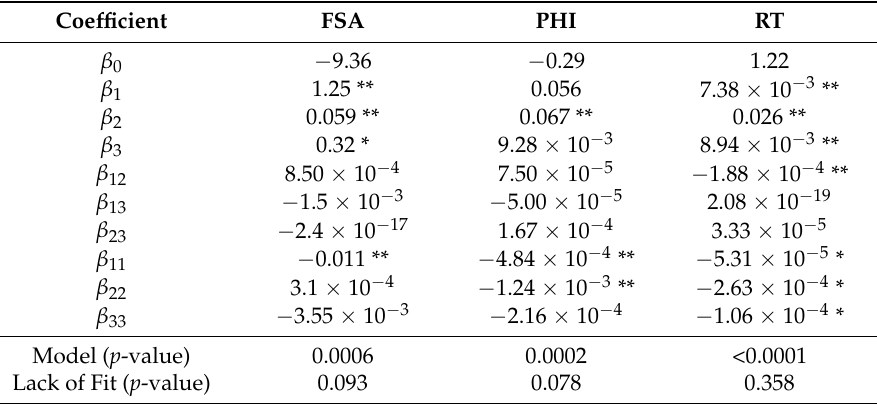
Table 2. Estimates of the model coefficients for the responses in